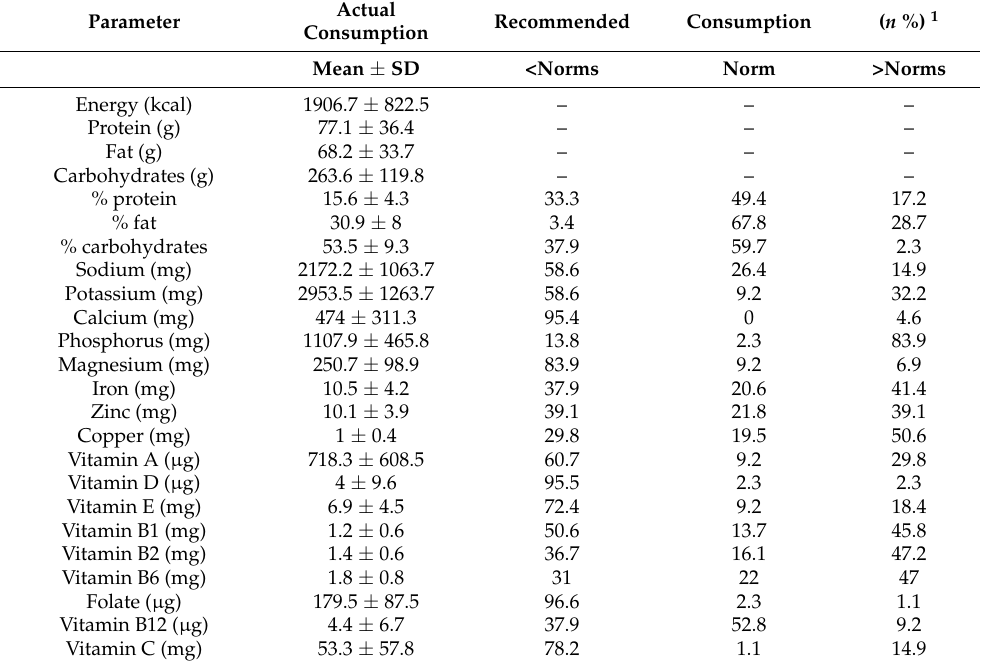
Table 3. Average consumption of macronutrients, vitamins and minerals and the percentage of patients with COPD treated with LTOT, who consumed an adequate amount of nutrients, an amount of nutrients below the recommended norm of consumption, and consumed the amount of nutrients above the recommended norm of consumption for the Polish population ( n = 110) [22].